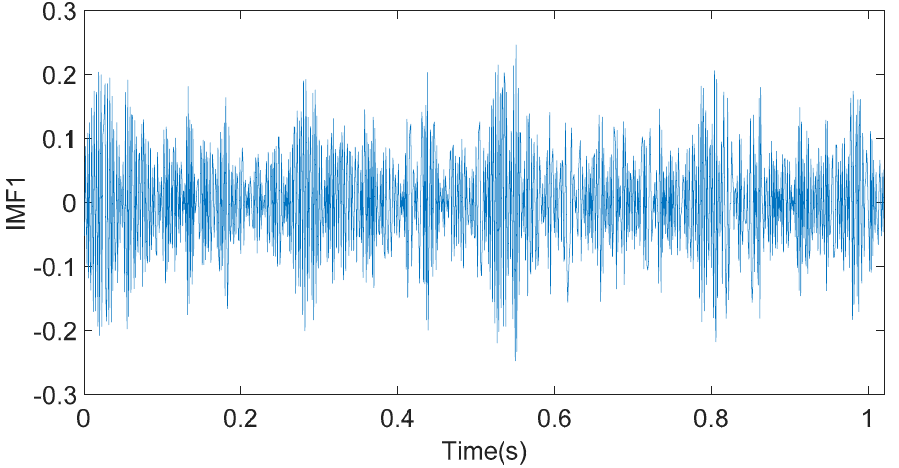
Figure 6. Time-domain waveform of the IMF1 component. Sensors 2020 , 20 , 1148